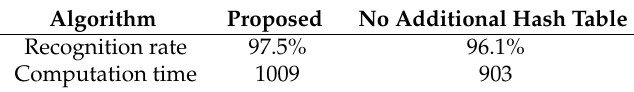
Table 5. Contribution of additional hash table on 8 objects.